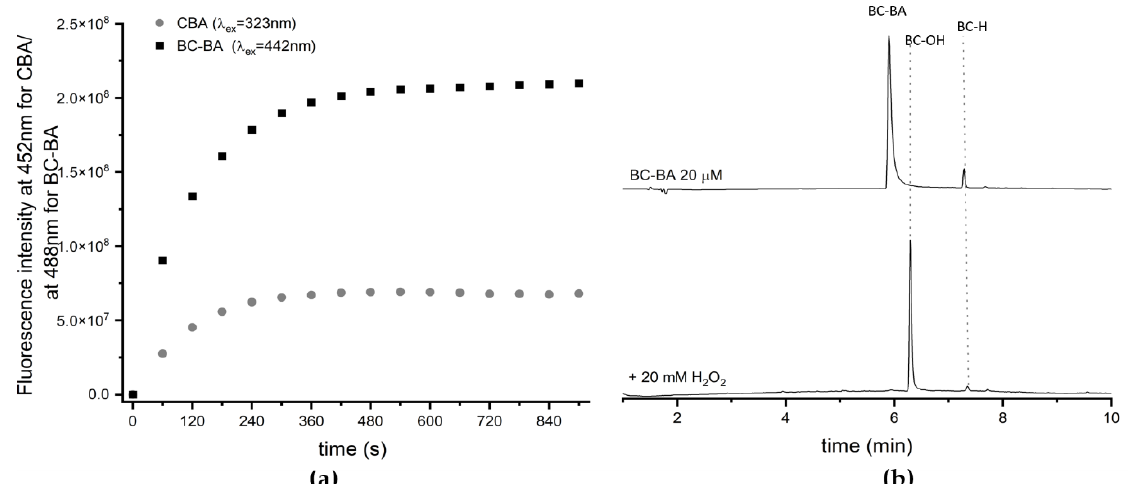
Figure 4. ( a ) Kinetic profiles of product formation during the oxidation of probes BC-BA and CBA (5 µ M each) by H 2 O 2 (5 mM). Experiments were repeated three times independently. Representative result displayed; ( b ) HPLC traces of the BC-BA probe (20 µ M) before and after addition of H 2 O 2 (20